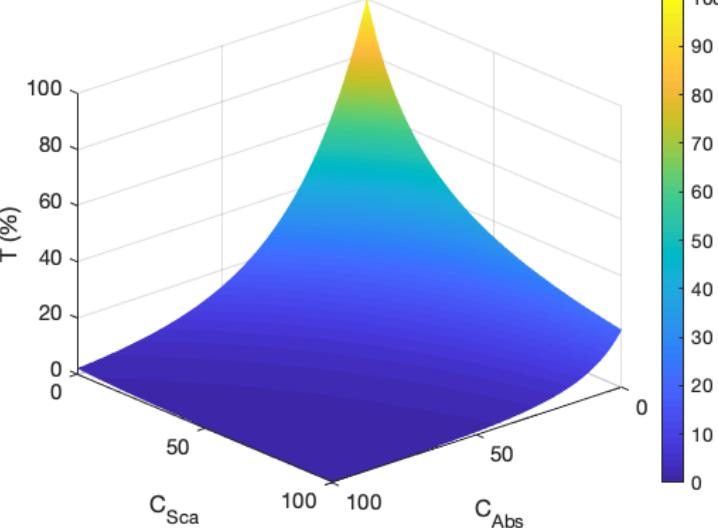
Figure 10. Transmission values with changing C Sca and C Abs ( µ m). As the extinction coefficient (the sum of the two) increases, the transmission decreases, however differing combinations of C Sca and C Abs can produce similar values. Therefore, we require more knowledge of the underlying physics of the problem in order to properly describe the transmission through the gel